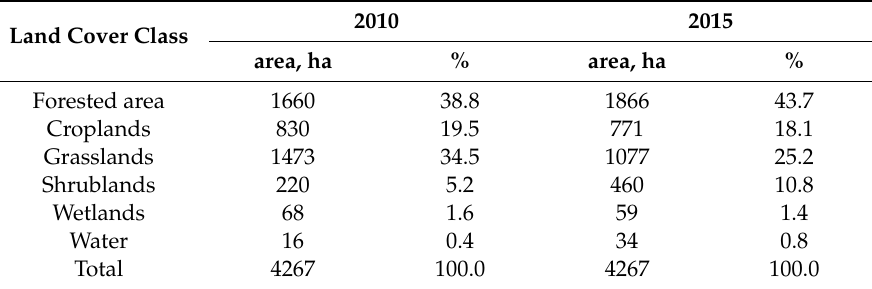
Table 1. Land cover distribution based on classification of satellite